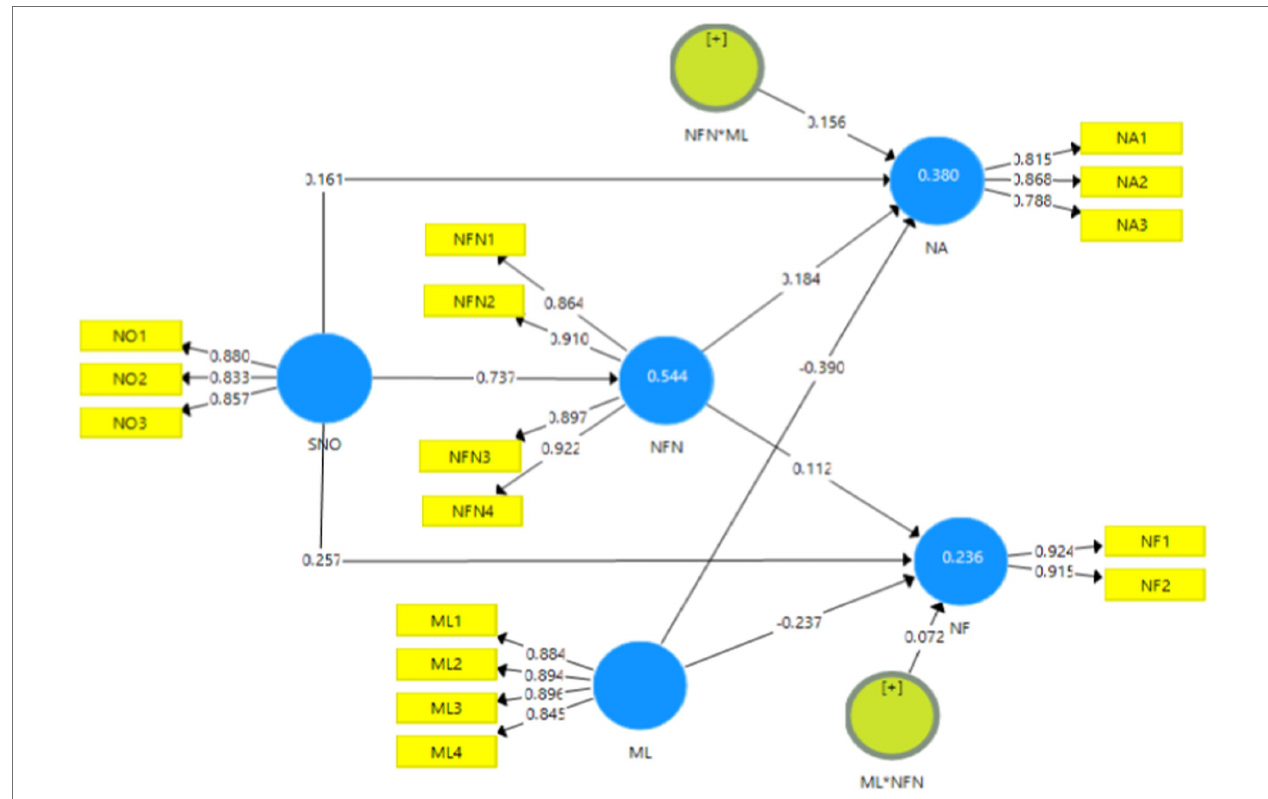
FIGURE 3 | Output of measurement model with moderation. SMO, Social Media Overload; NA, News Avoidance; NF, News Filtering; NFN, Need for News; and ML, Media Literacy.